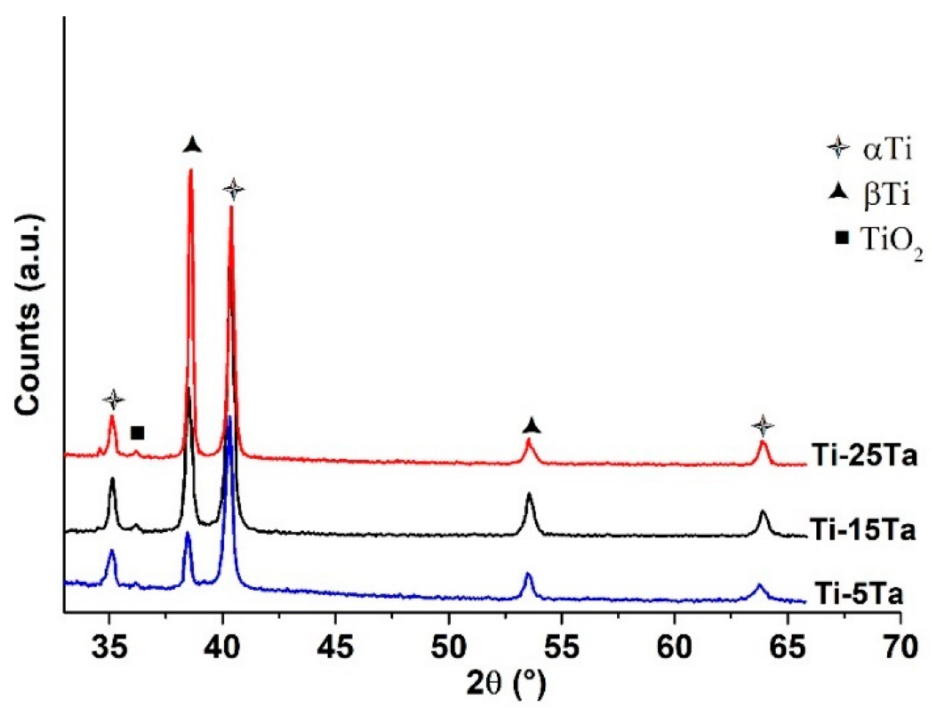
Figure 4. XRD spectra of the investigated samples: blue—Ti-5%Ta, black—Ti-15%Ta and